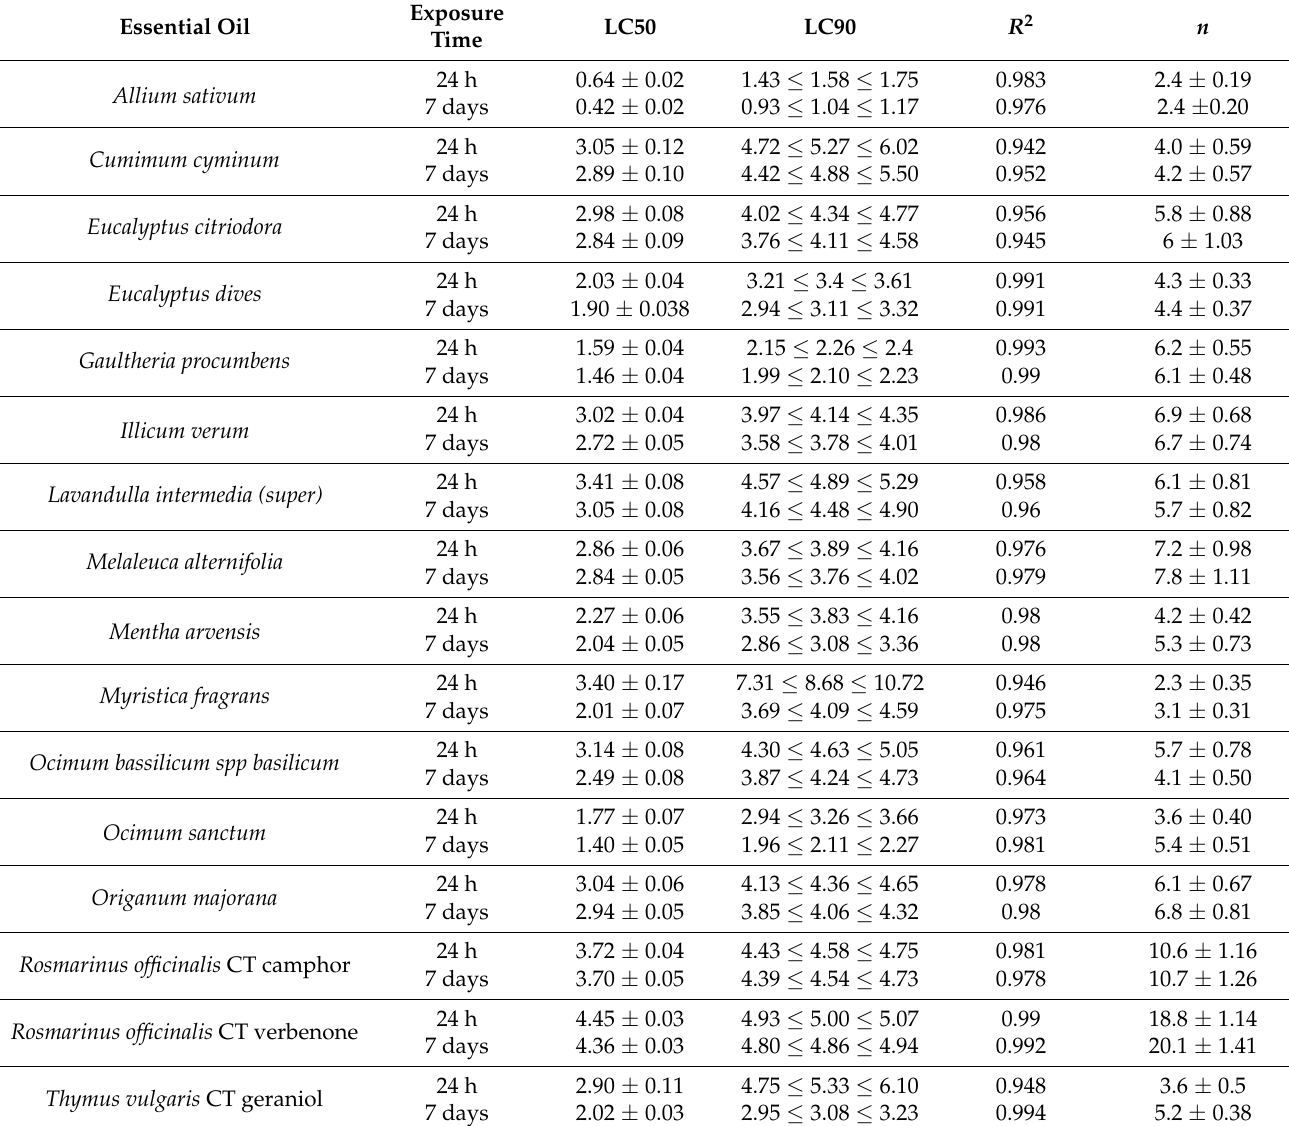
Table 4. Summary of mortality data presented at the Figure 1 for the 16 essential oils tested. Lethal concentrations are expressed in